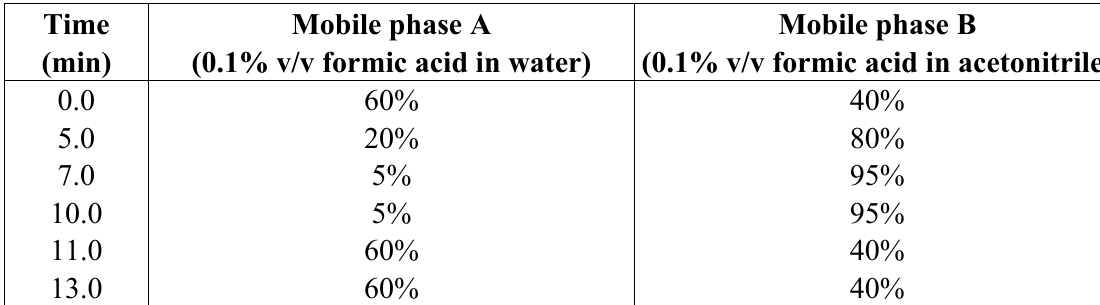
Table 1. Liquid chromatography